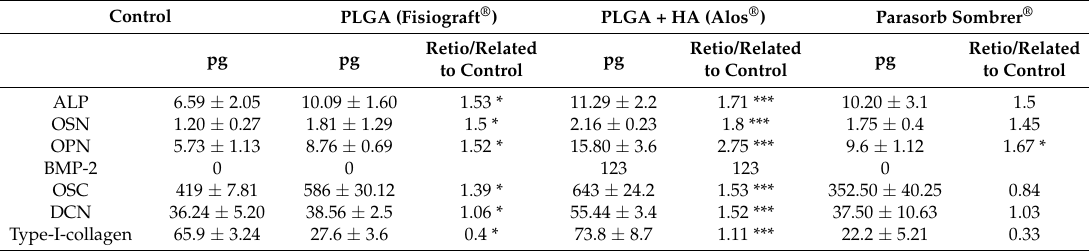
Table 2. Protein titration of bone extracellular matrix produced by hPCs cultured for 28 days in a proliferative medium on plastic, PLGA-Fisiograft, PLGA/HA-Alos, and PARASORB Sombrero. Results are expressed as protein quantity (pg)/2 μ g and are presented as an average of three measurements from two separate experiments. Control PLGA (Fisiograft ® ) PLGA + HA (Alos ® )